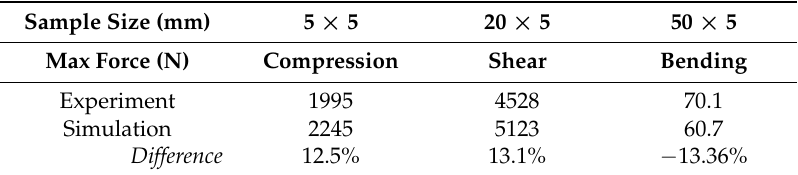
Table 5. Simulation vs experiment in terms of maximum